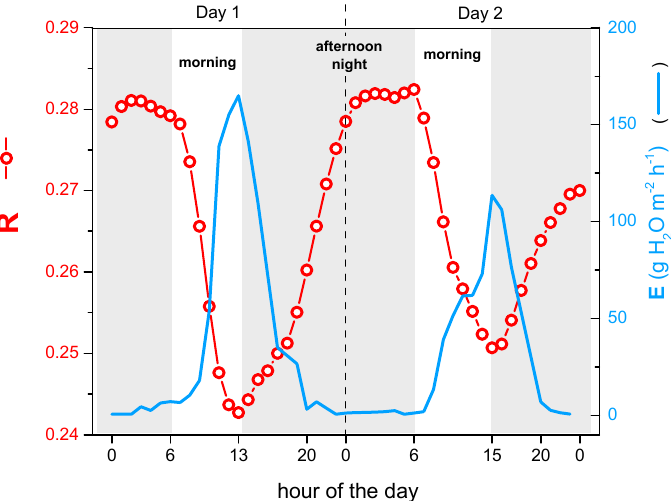
Figure 2. Diurnal variations of R ( ○ ) and plant transpiration (E) (continuous line) recorded over two consecutive days. The vertical dashed line separates the two consecutive days (8 and 9 April).